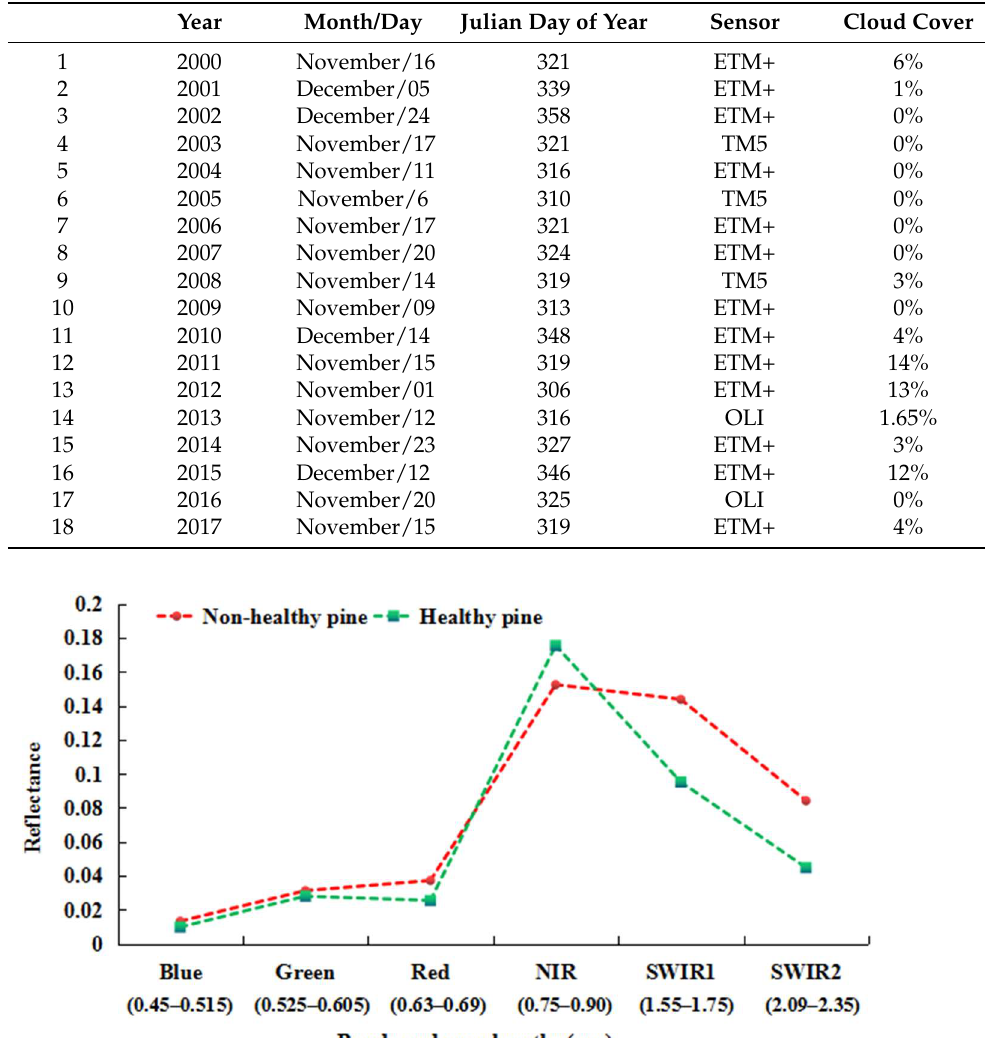
Table 1. Landsat TM, ETM+, OLI images used in time series analysis.